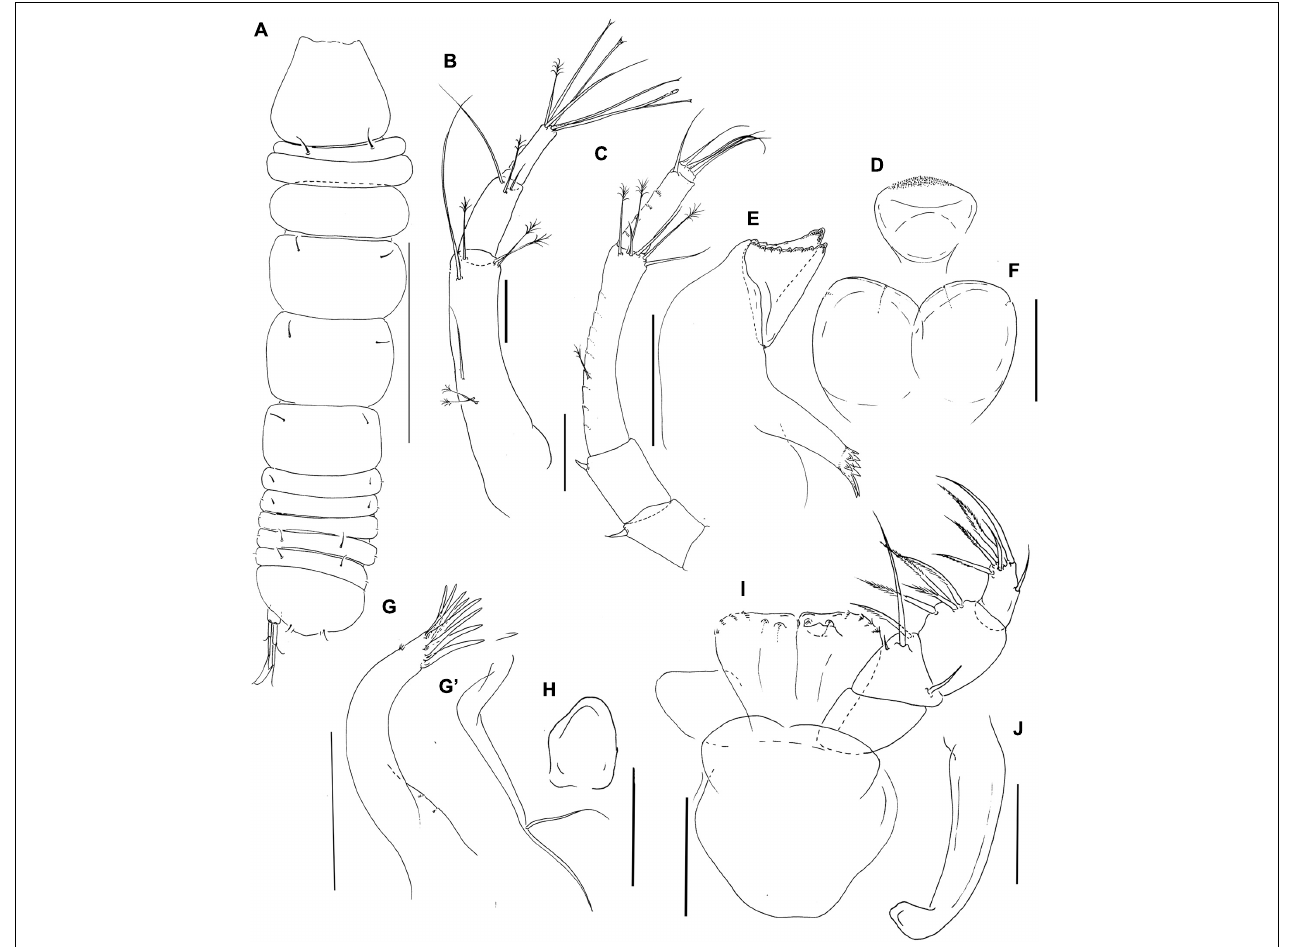
FIGURE 8 | Pseudotanais coonawarrai sp. nov; neuter (J62734), (A) , dorsal; (B) , antennule; (C) , antenna; (D) , labrum; (E) , left mandible; (F) , labium; (G) , maxillule; (G’) maxillule endite; (H) , maxilla; (I) , maxilliped; (J) , epignath. Scale lines (A) = 1 mm, (B–I) = 0.1